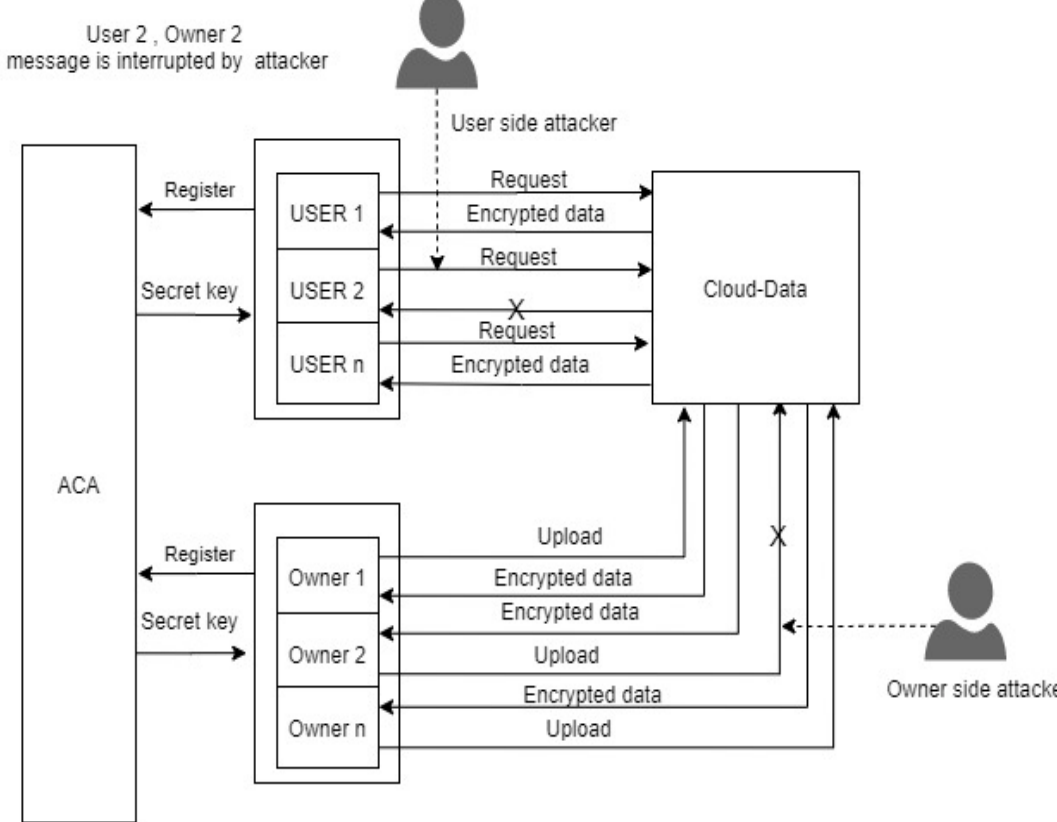
Figure 2. The security model of proposed RSA-CP-IDABE.